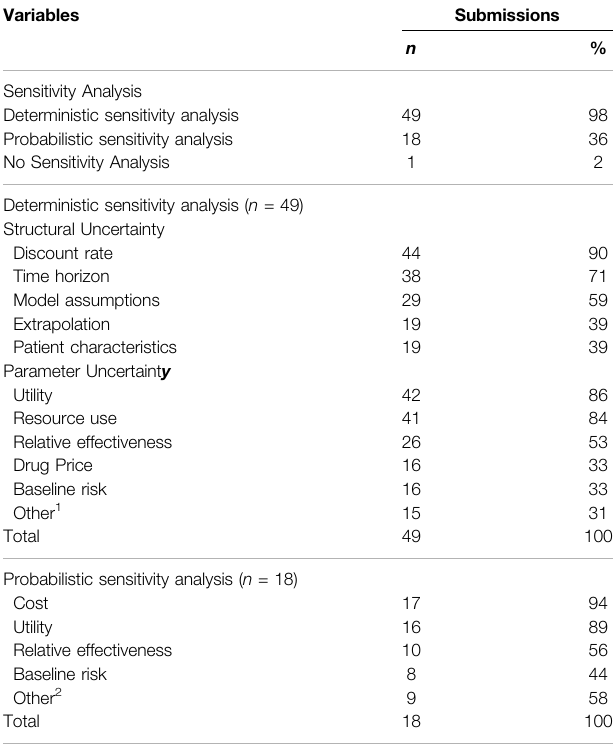
TABLE 1 | Basic characteristics of the 50 dossiers submitted to the Economic Sub-Committee for listing at the Korean National Health Insurance.